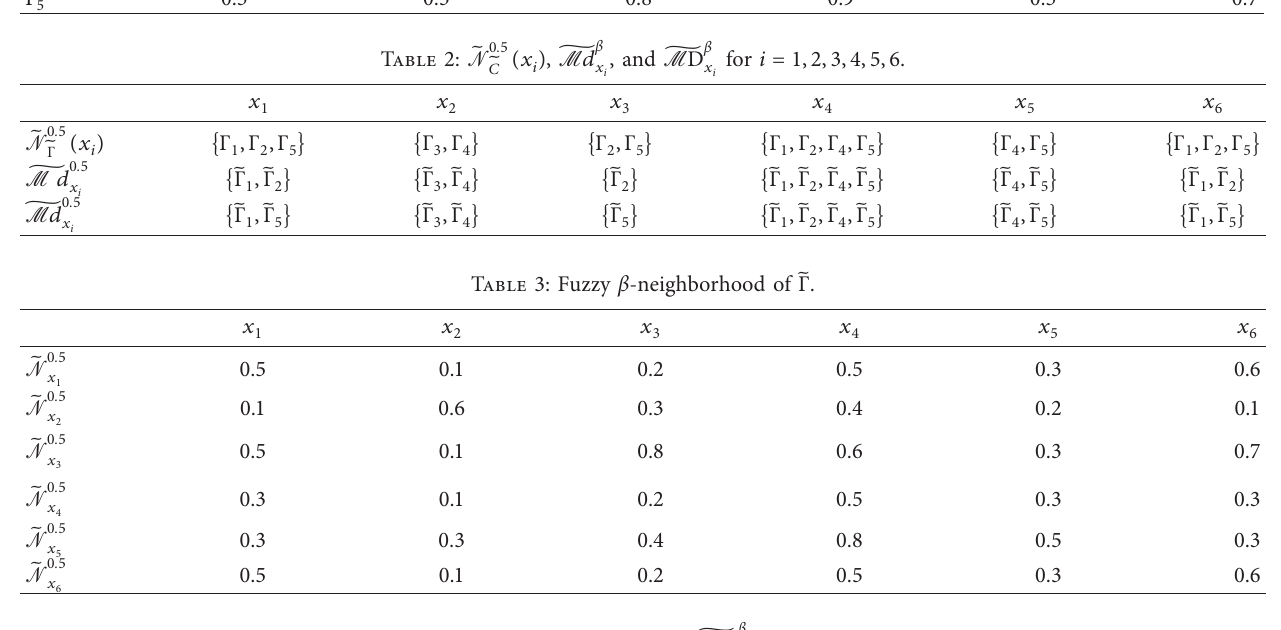
Table 4: Values of ∨ 􏽧 M d β